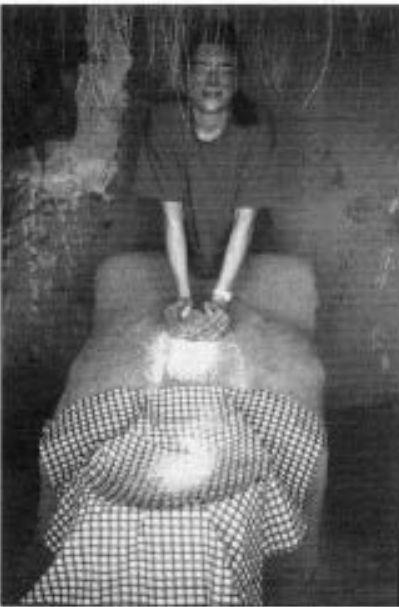
Figure 8 The author grinding flour with an ancient Egyptian handstone and grind­ stone set in a replica